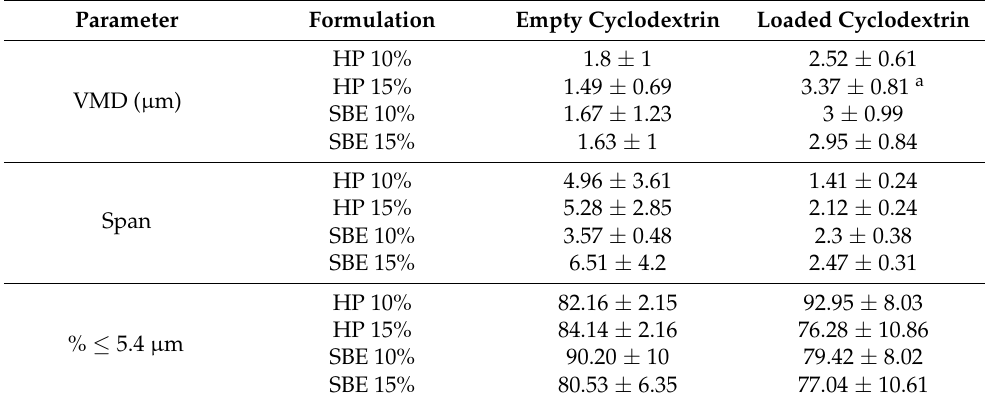
Table 2. VMD, Span, and % ≤ 5.4 µm of each empty CD (10% and 15%), and each CD (10% and 15%) loaded with DS (mean ± SD, n = 3).